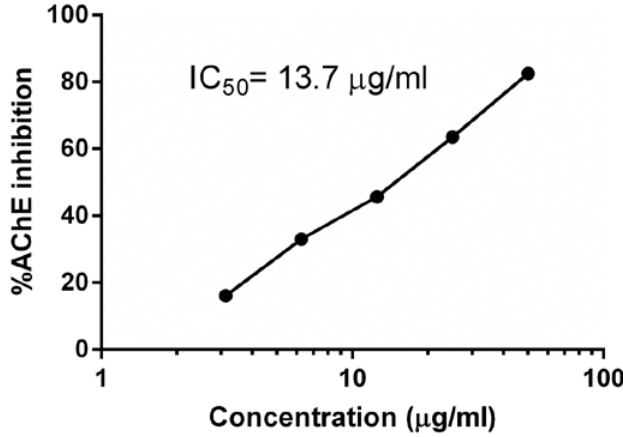
FIGURE 2 - Concentration-dependent effect of P. atropurpureus chloroform fraction on AChE enzyme Inhibition. IC inhibition was derived using non-linear regression analysis on GraphPad Prism V6.0.